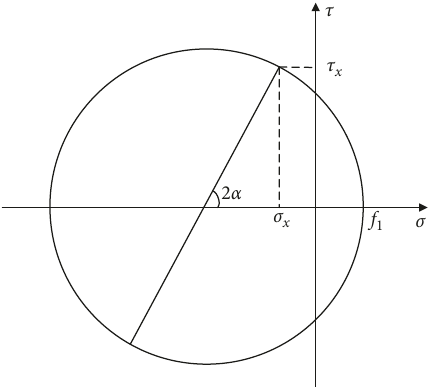
Figure 14: Mohr’s circle of